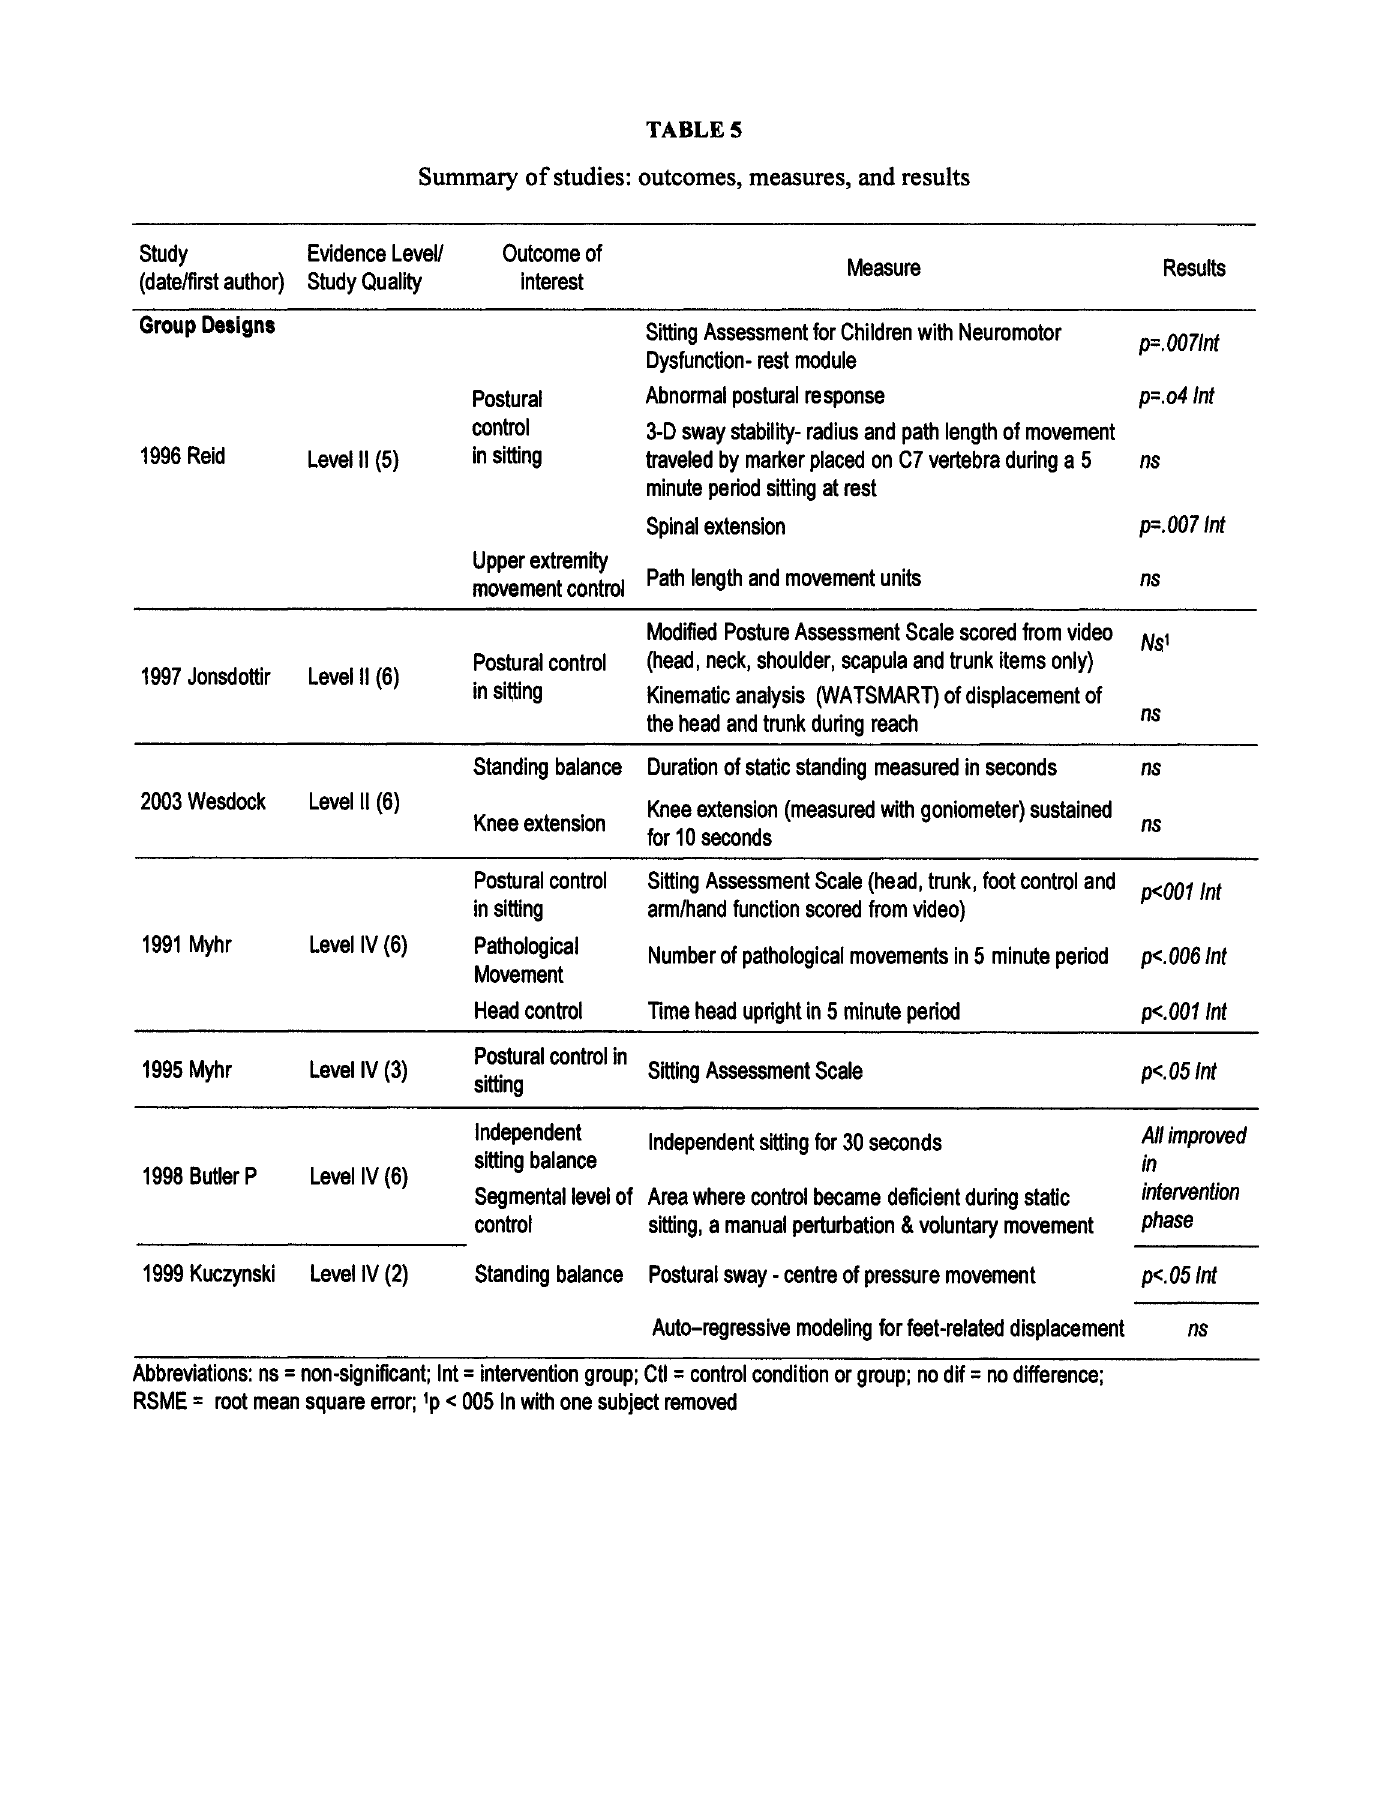
Summary of studies: outcomes, measures, and